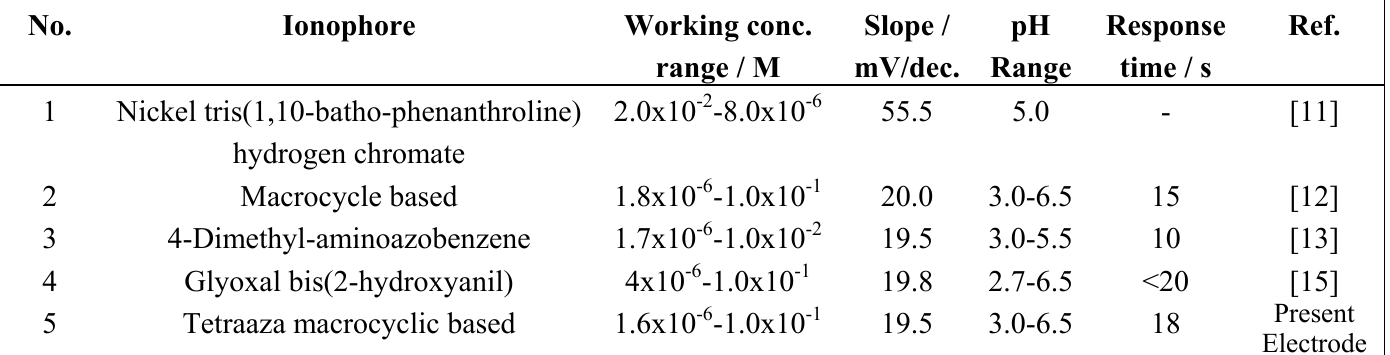
Table 1. Comparative studies of previously reported literature based on Cr 3+ ion-selective